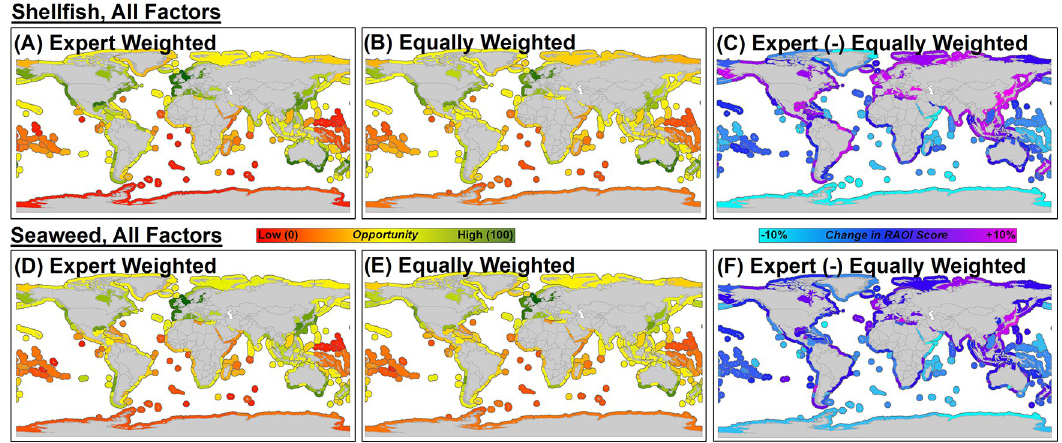
Fig 6. Comparison of identified high (green) to low (red) opportunity marine ecoregions between the stakeholder, expert-weighted models that incorporated all environmental, socioeconomic, and human health factors for shellfish (A) and seaweed (D), and the equally weighted models that incorporated all factors for shellfish (B) and seaweed (E). The differential maps for shellfish (C) and seaweed (F) represent the subtraction of the RAOI scores for the equally weighted models from the expert-weighted models. For example, marine ecoregions with changes in RAOI score close to +10% (magenta) represent those with the greatest increase in RAOI score under the expert-weighted model relative to the equally weighted model. Factors included in each scenario and associated weightings are provided in Table